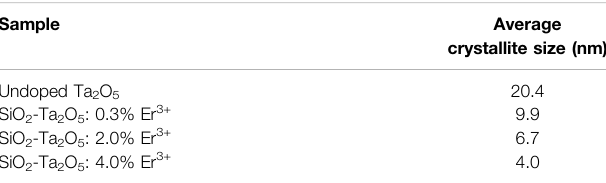
TABLE 2 | Average crystallite diameters of undoped Ta 2 O 5 and 0.3, 2.0, and 4.0 mol% Er 3+ -doped SiO 2 -Ta 2 O 5 nanocomposites calcined at 1100 ° C for 8 h.